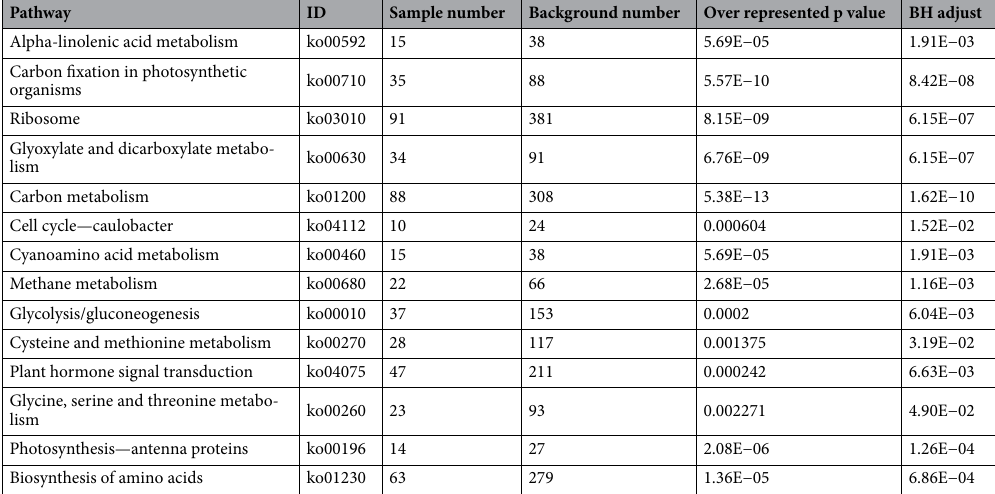
Table 5. Enrichment results of KEGG of DEGs.